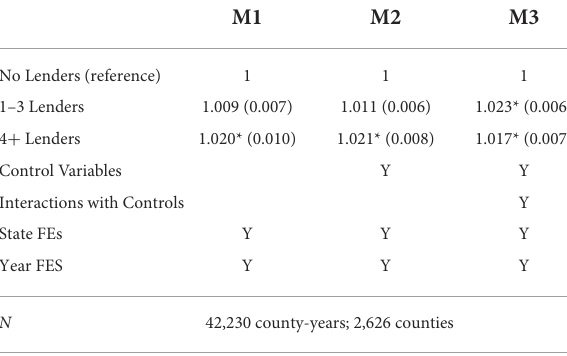
TABLE 2 Unadjusted and adjusted incidence risk ratios for premature deaths, by lender presence. M1 M2